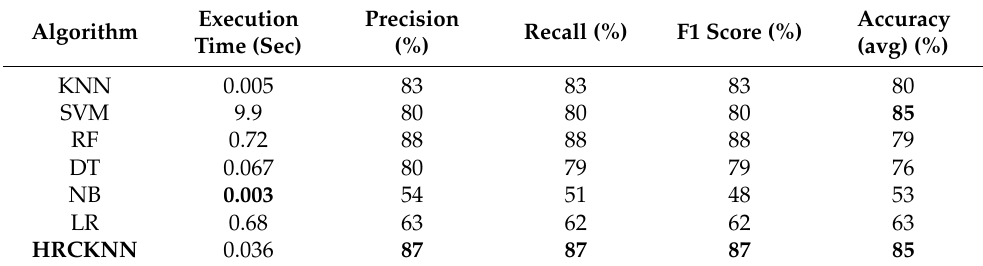
Table 3. Performance Comparison of Machine Learning Algorithms with HRCKNN.